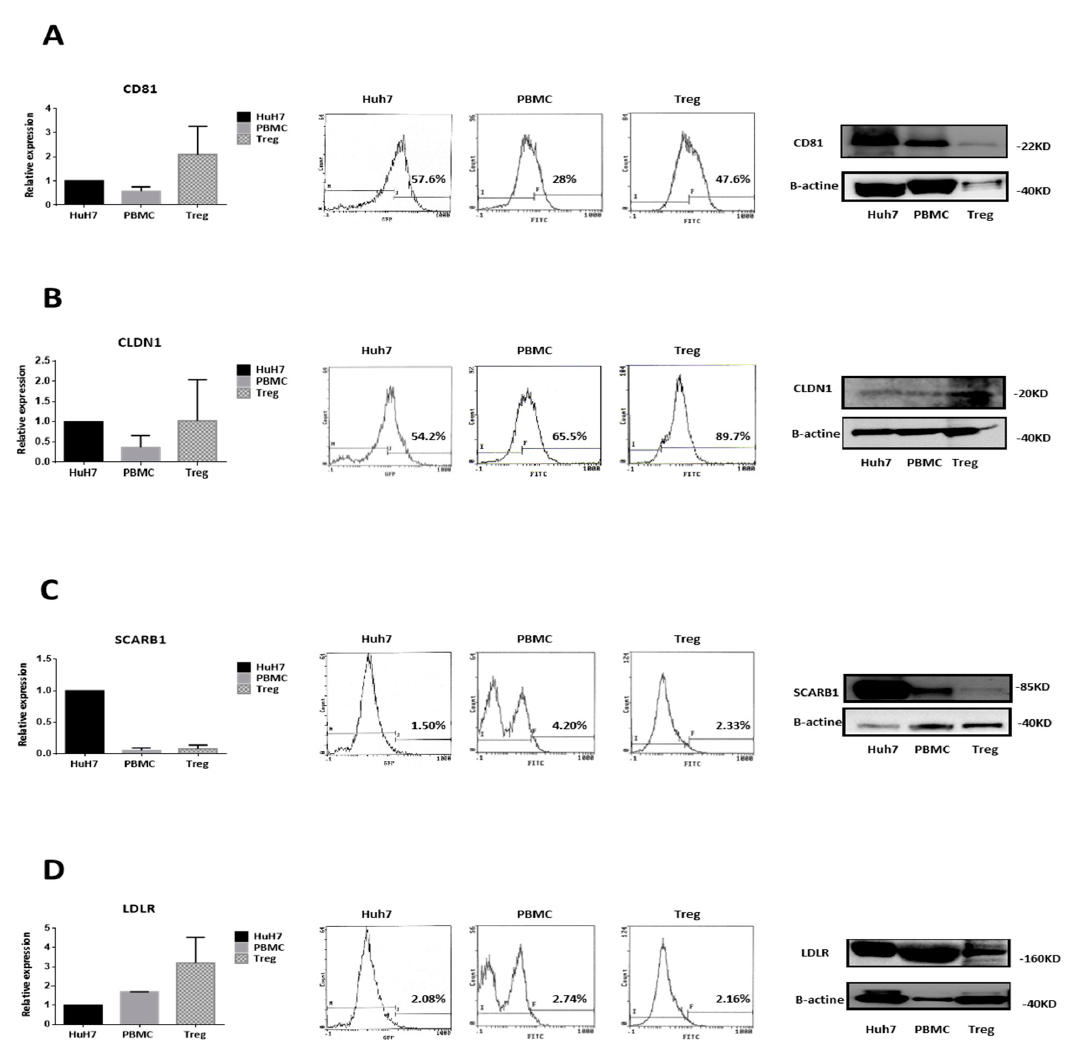
Figure 1. Tregs possess the classical hepatitis C virus (HCV) entry receptors: CD81, CLDN1 and LDLR. Gene expression analyses (qPCR) of receptors CD81 ( A ), CLDN1 ( B ), SCARB1 ( C ) and LDLR ( D ), associated with HCV entry in host cells (left panels). Results are expressed as relative expression and presented as means of four independent experiments ± standard error of the mean (SEM) bars. Protein expression Flow Cytometry (FACS) of receptors related to HCV entry (middle panels). Results are expressed in histograms displaying the percentage of cells positive for protein labeling compared to isotype control. Protein expression (Western Blot) of receptors linked to HCV entry (right panels). Analyses were performed on Huh7 (control), PBMC and Tregs. The images are representative of at least four independent